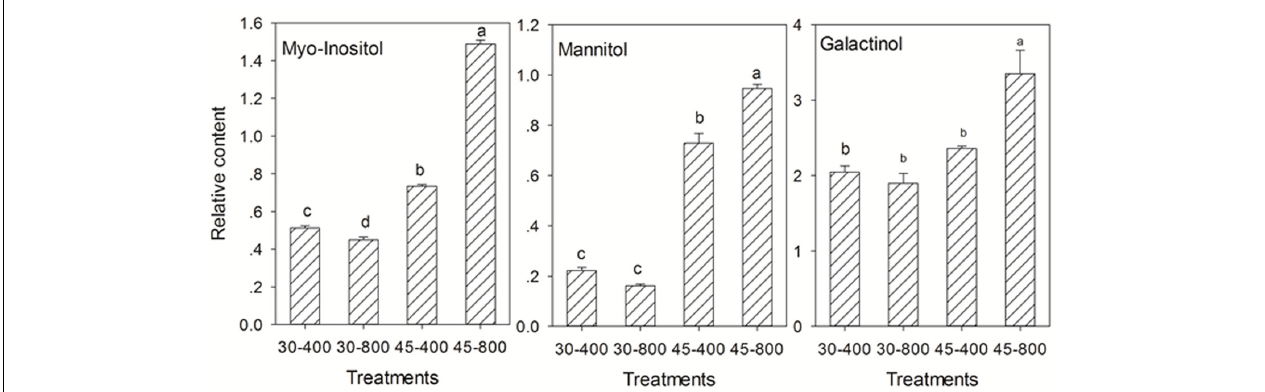
FIGURE 7 | Effects of elevated CO 2 concentration on sugar alcohols in response to heat stress in bermudagrass. The treatments symbols are 30 and 45 for normal temperature control and heat stress and 400 and 800 for ambient CO 2 and elevated CO 2 concentrations, respectively. Columns marked with different letters presented the significant differences based on LSD values ( P ≤ 0.05) among